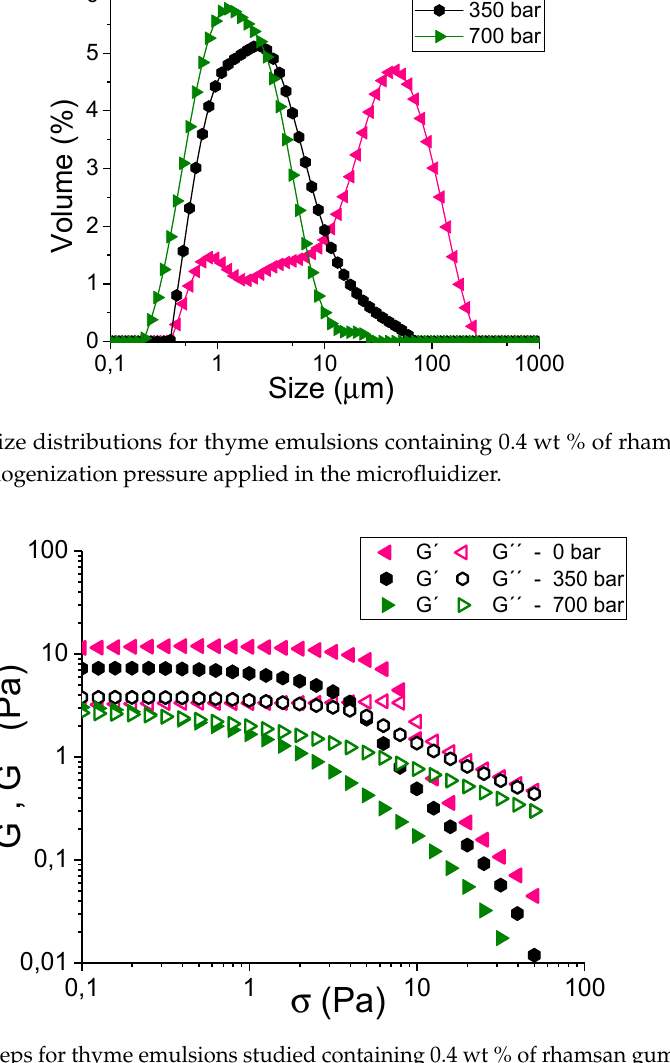
Figure 7. Turbiscan Stability Index parameter for thyme emulsions studied containing 0.4 wt % of rhamsan gum as a function of the homogenization pressure applied in the microfluidizer. 4. Conclusions The influence of the gums’ concentration ratio and homogenization pressure on the critical shear stress of dispersions containing a blend of welan and rhamsan gums was studied using design of experiments and surface response methodology. In order to rationally develop the formulation and processing conditions of biopolymer dispersions prepared with a microfluidizer, a quadratic model was required. An increase in the welan gum concentration and homogenization pressure provoked